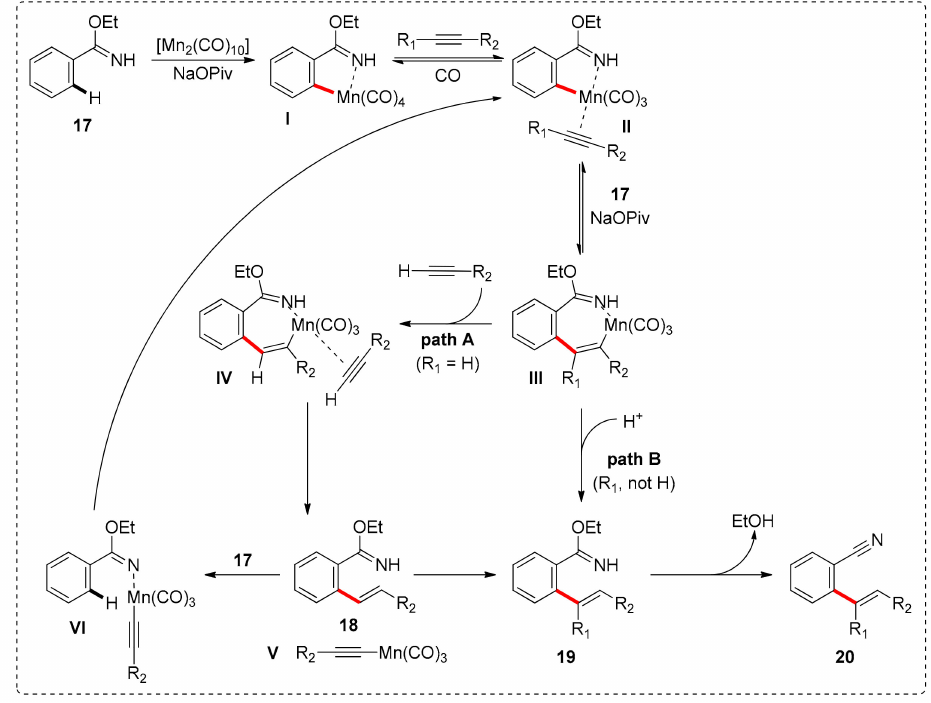
Scheme 2. Proposed catalytic